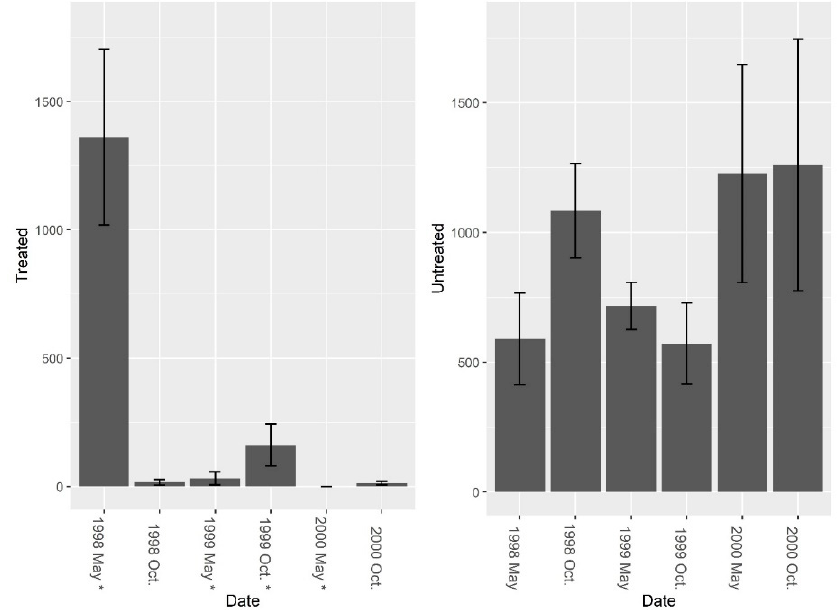
Figure 2. Mean ( ± 1 SE) fire ant abundance from burrow baits at five pairs of treated and untreated study sites at CSJFTC, 1998–2000. Fire ant abundance declined 98.8% in treated sites, and increased 53.2% in untreated sites. Post-treatment data were compared using a repeated measures randomized block ANOVA, and repeated LOGIC ® applications significantly reduced fire ant abundance at treated sites (F 1, 8 = 24.78, P = 0.001). Asterisks on the x-axis indicate when treatments occurred.